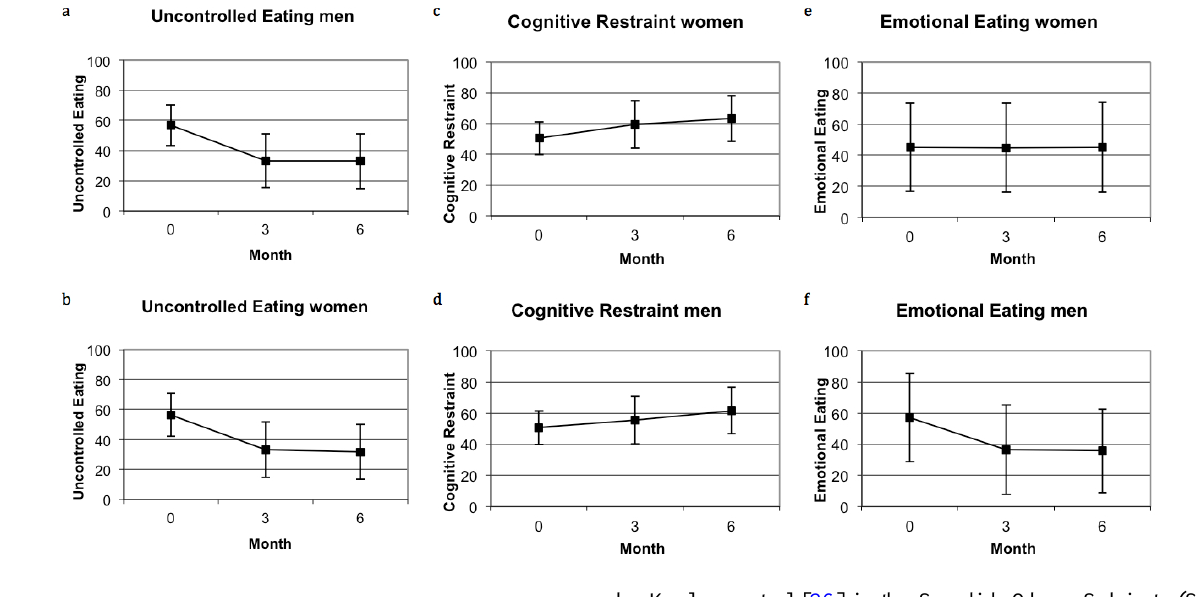
Figure 4. Change over time in uncontrolled eating behavior a) among women (n=524) and b) among men (n=96). Change over time in cognitive restraint eating behavior c) among women (n=524) and d) among men (n=96). Change over time in emotional eating behavior e) among women (n=524) and f) among men